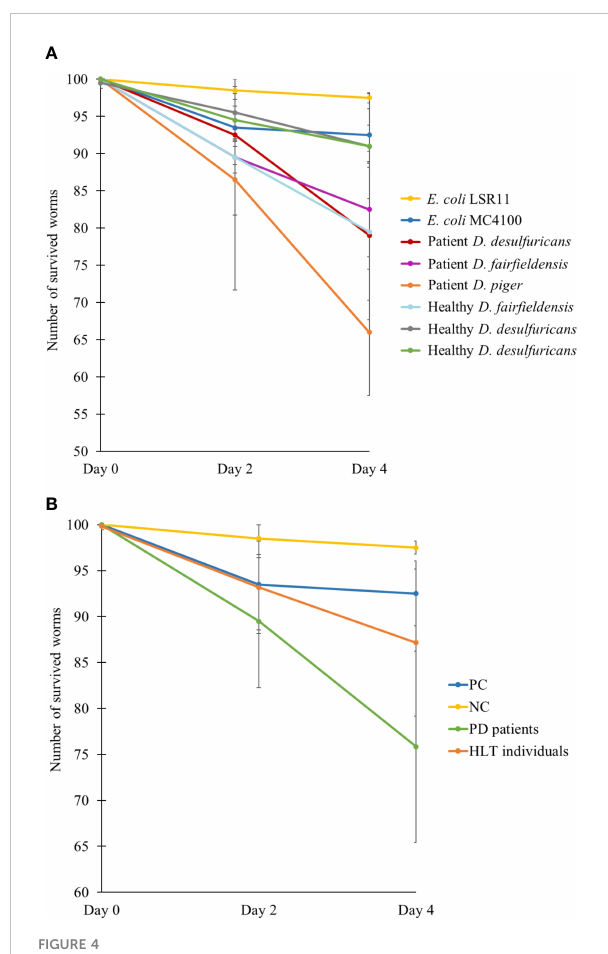
FIGURE 4 Number of survived worms after two and four days feeding on different bacteria, demonstrated individually (A) or as groups (B) . NC: E. coli LSR11 (negative control), PC: E. coli MC4100 (positive control), PD patients: DSV strains from patients with PD, HLT individuals: DSV strains from healthy individuals. Data are presented as mean ±